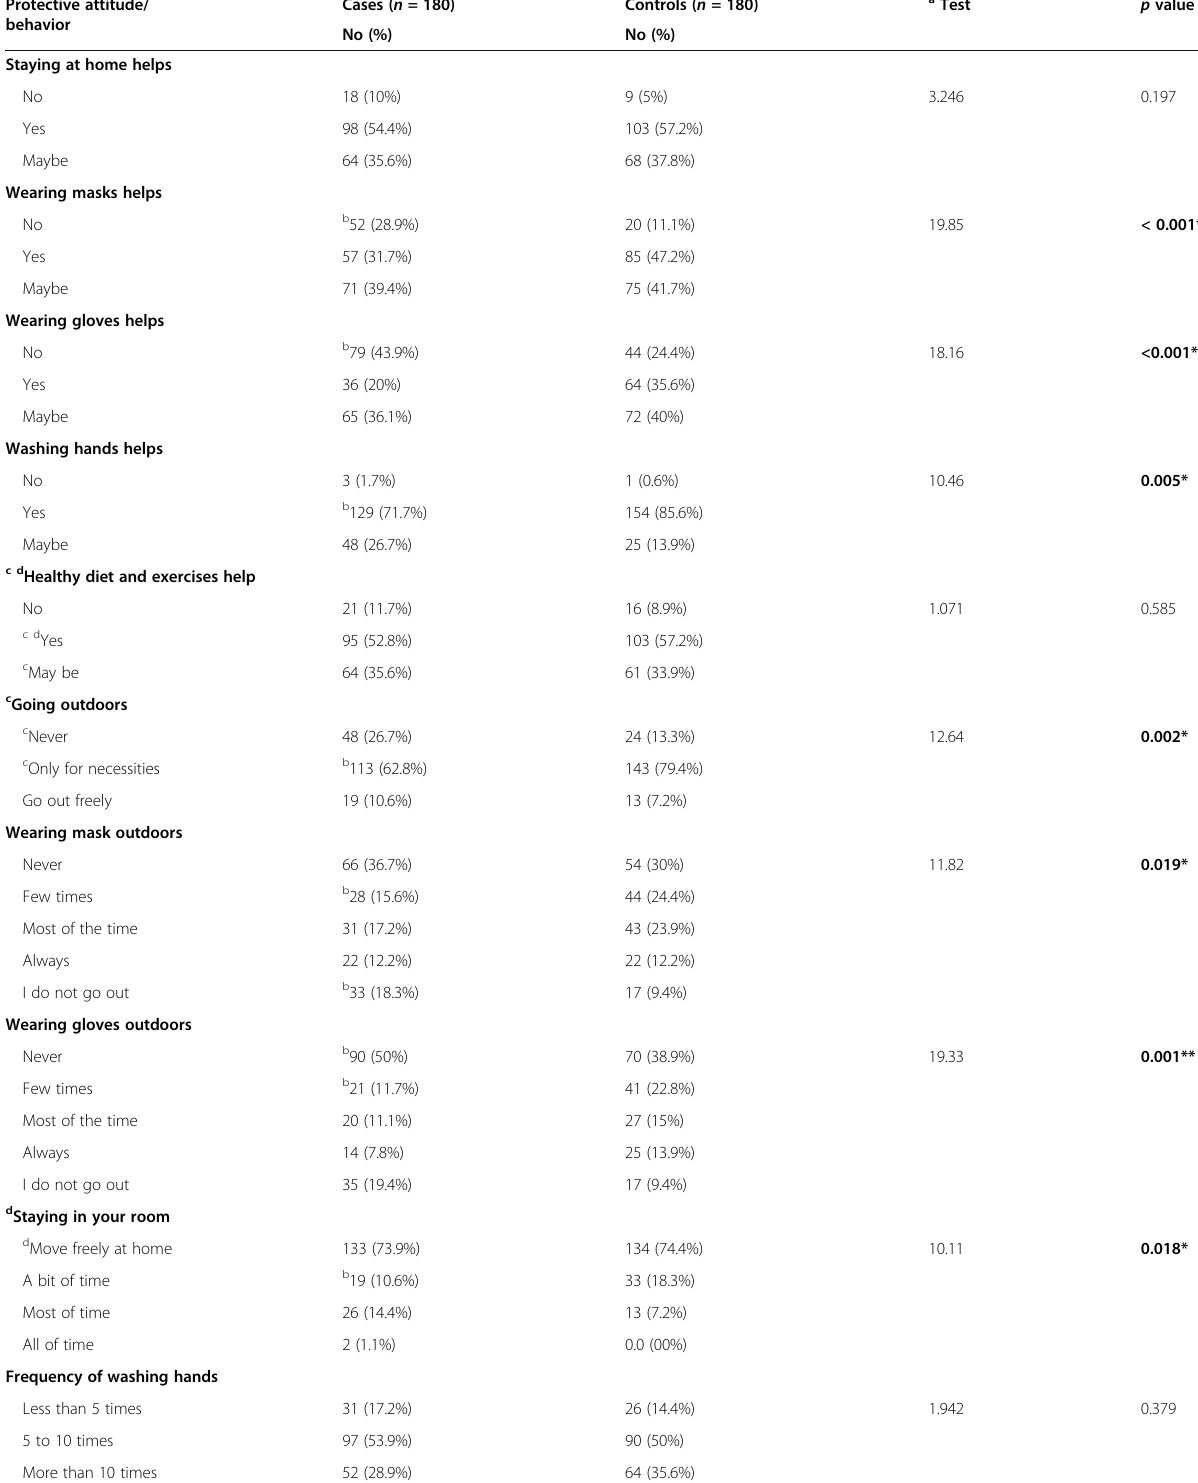
Table 2 Attitude and behaviour regarding COVID among the studied groups ( n =